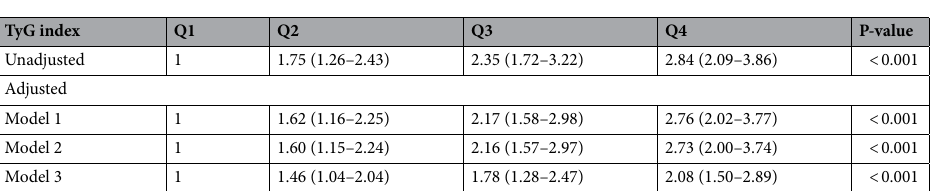
Table 4. Multivariate logistic regression analysis for the risk of low muscle mass according to the quartiles of the TyG index. Model 1: age and sex. Model 2: age, sex, current smoker, heavy alcohol consumption, and regular exercise. Model 3: age, sex, current smoker, heavy alcohol consumption, regular exercise, systolic blood pressure, creatinine, aspartate aminotransferase, alanine aminotransferase, total cholesterol, and vitamin